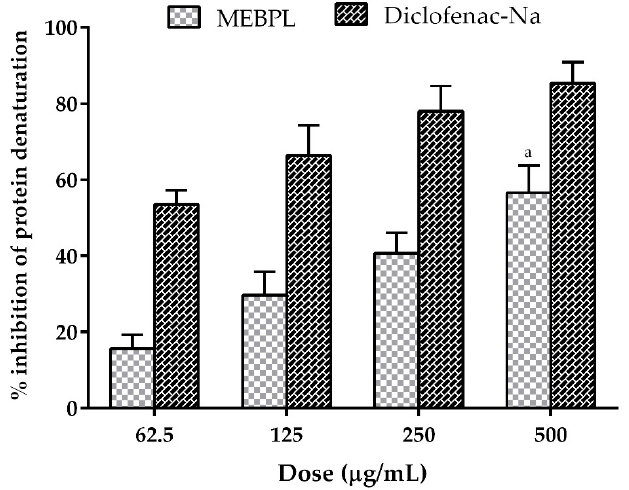
Figure 2. Percentages of protein denaturation by methanol extract of B. pilosa leaves (MEBPL) and standard drug diclofenac sodium. Values are mean ± SEM ( n = 3). a p < 0.05, significantly different from control.